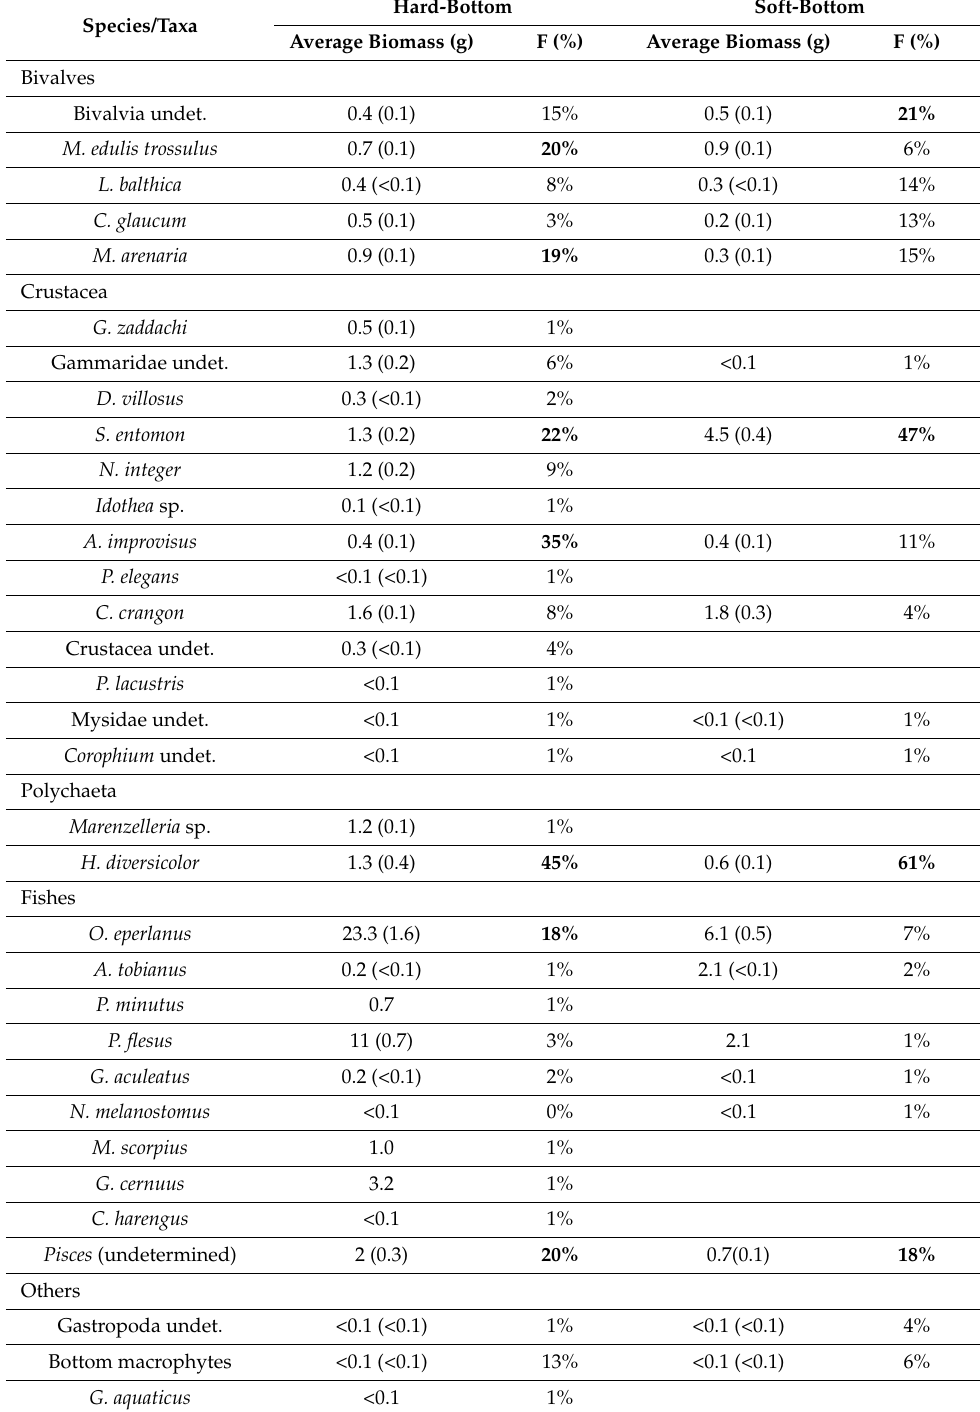
Table 4. Average prey biomass (standard error) and frequency (F%) in the stomach samples of long-tailed ducks collected from 2016 to 2020 in hard- and soft-bottom habitats of coastal waters. Main prey groups (F > 15%) are shown in